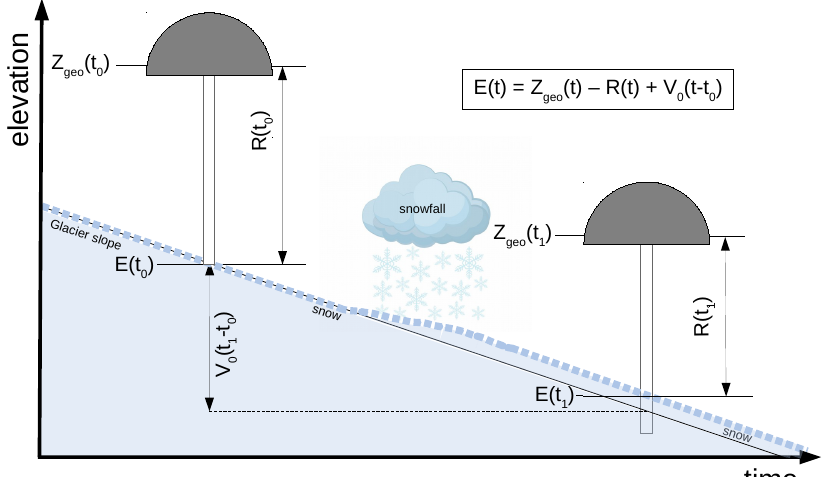
Figure 5. Schematics of an antenna located on a glacier. In this case, as time passes, an additional component enters the elevation calculation, which is the downhill motion due to the physical slope of the